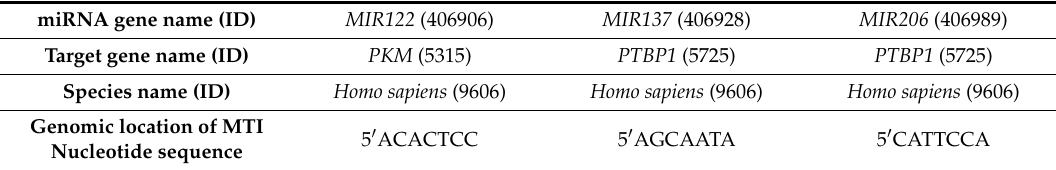
Figure 1. Pyruvate kinase (PK) different forms and PK enzymes regulating miRNAs showed organ specificity. ( A ) Expression profile of PKM1 , PKM2 , pyruvate kinase L/R ( PKLR ), and PTBP1 in tissues from mouse organs. β -actin and glyceraldehyde-3-phosphate dehydrogenase ( GAPDH ) were used as internal controls; ( B ) Expression profile of MIR 137 ( Left panel), MIR206 ( Middle panel), and MIR122 ( Right panel) in tissues from mouse organs; ( C ) Profiles of the same miRNAs in tissues from human organs. The expression level is presented as a relative value compared with the tissue that had the highest expression level in each miRNA. Notably, normalization was not performed in this case because the organ specificities of these miRNAs were strong enough so as not to be affected by normalization. Human brain cortex and liver were obtained from Biochain, and others from Clontech. Results are presented as the mean ± standard deviation (SD); *** p < 0.001; N.D., not detected. Table 1. Validations of microRNAs (miRNAs) used in this